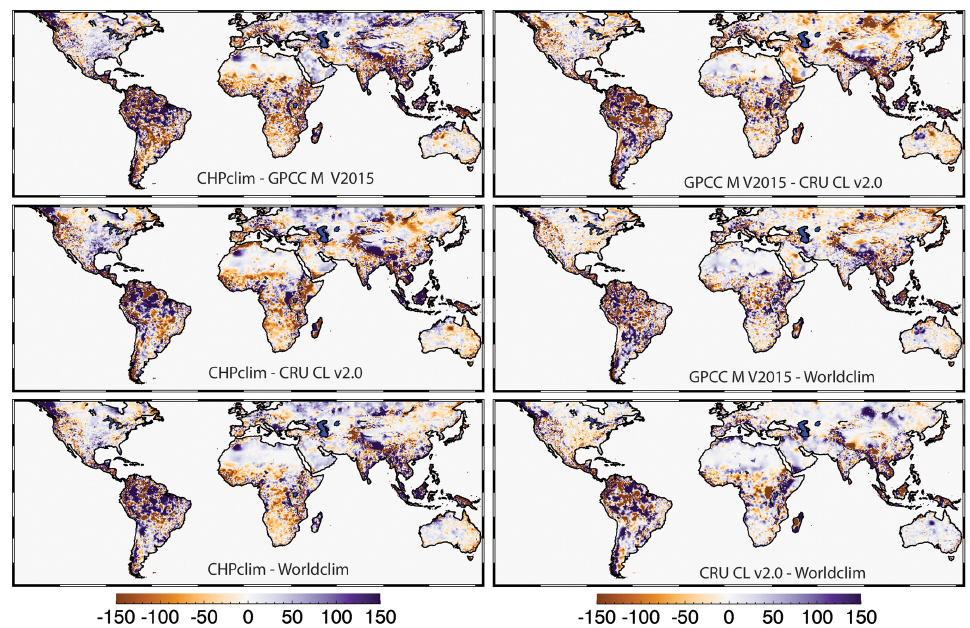
Figure 9. Differences in annual total precipitation for CHPclim, the 0.25 ◦ GPCC M V2015 climatology, the 0.17 ◦ CRU CL v2.0, and the 0.042 ◦ version 1.4 release 3 Worldclim climatology. Table 2. Comparison on annual total precipitation [mm] for different regions. Globe, excl Europe Asia Australia Maritime